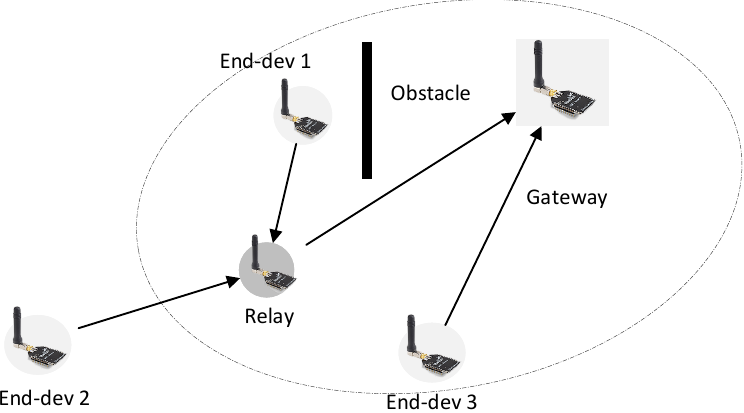
Figure 1. Ideal use of a relay. Not all end-devices require relays to preserve reliability. Relay is only useful for extending coverage and forwarding packet from a blocked